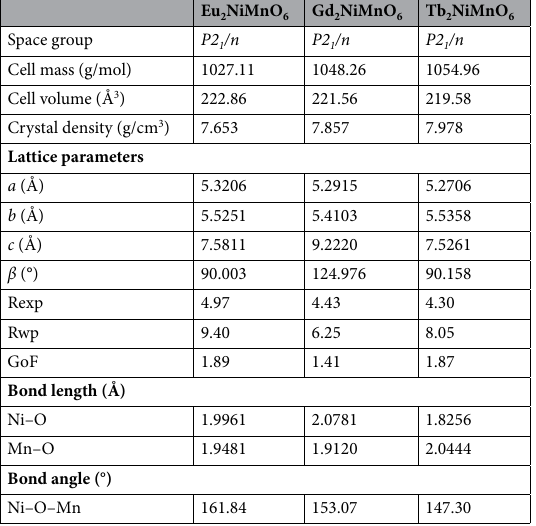
Table 1. Structural parameters for ENMO, GNMO, and TNMO from the Rietveld